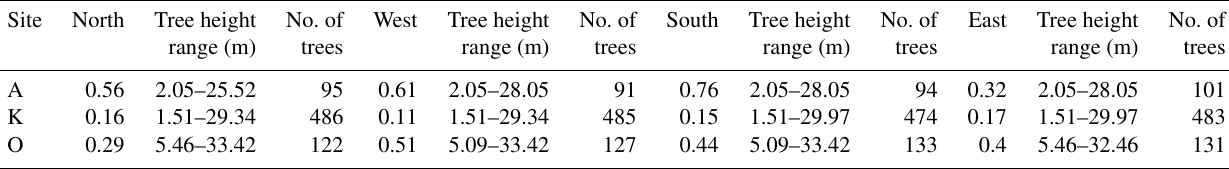
Table A3. Relationship between tree height and snow depth (within a 10m transition zone) based on cardinal direction. The columns are site, adjusted R 2 , tree height range, and number of trees. Ranges of tree heights vary within sites because not all trees had adequate snow samples to test in all cardinal